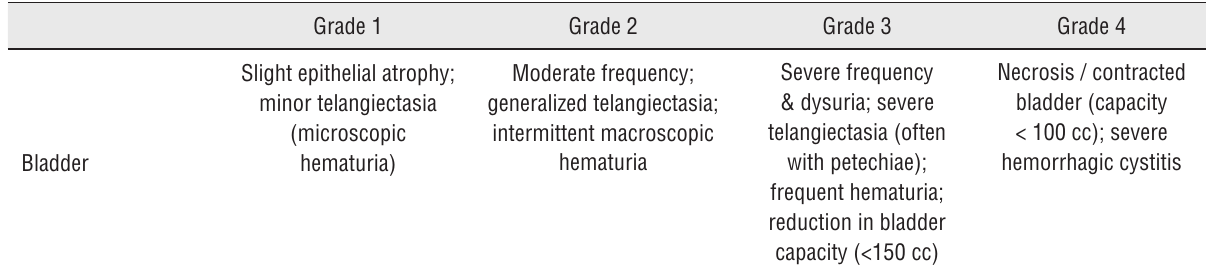
Figure 5 - RTOG score, used to evaluate late urinary toxicity (>3 months). Only a minority of the patients had urinary complaints. Dysuria and frequency (grade 2) were the most common urinary side-effects of the treatment. Hematuria was only present in 1.4% of the patients.